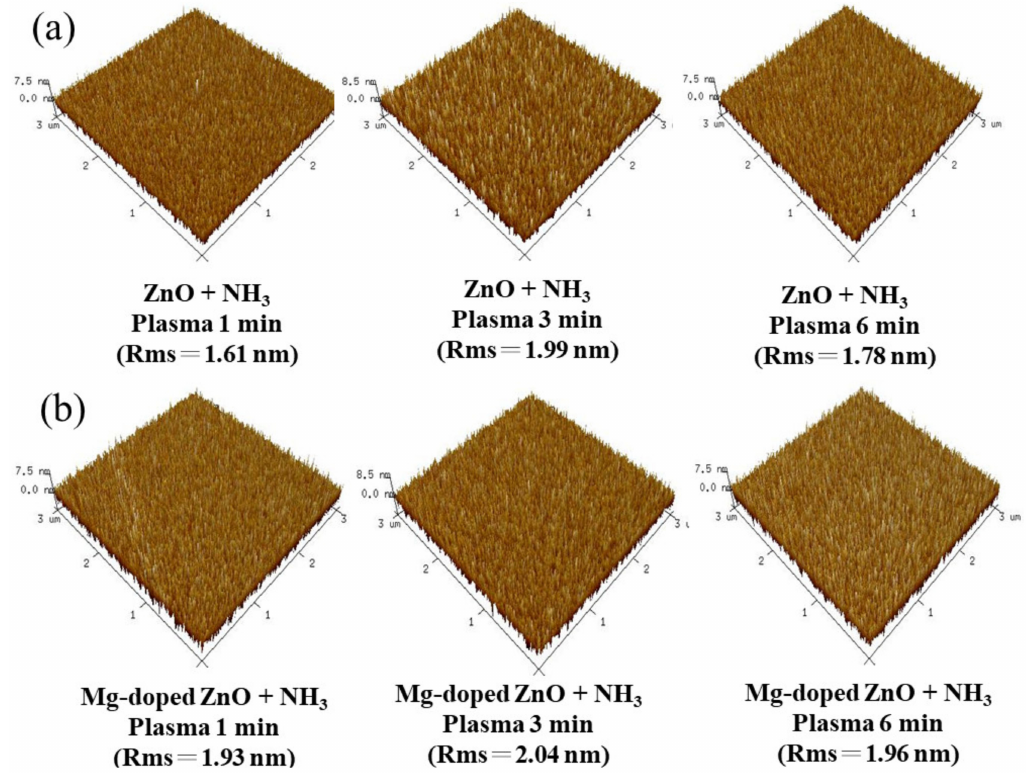
Figure 3. AFM of surface of ( a ) ZO sample treated with NH 3 plasma for 1 min, 3 min, and 6 min; ( b ) MZO sample treated with NH 3 plasma for 1 min, 3 min, and 6